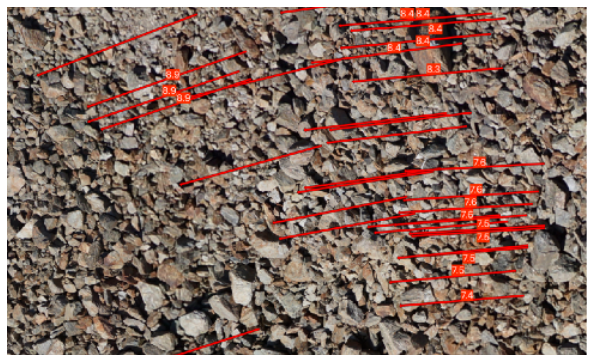
Figure 7. Local optical flow filter for tracked movements between 2017 and